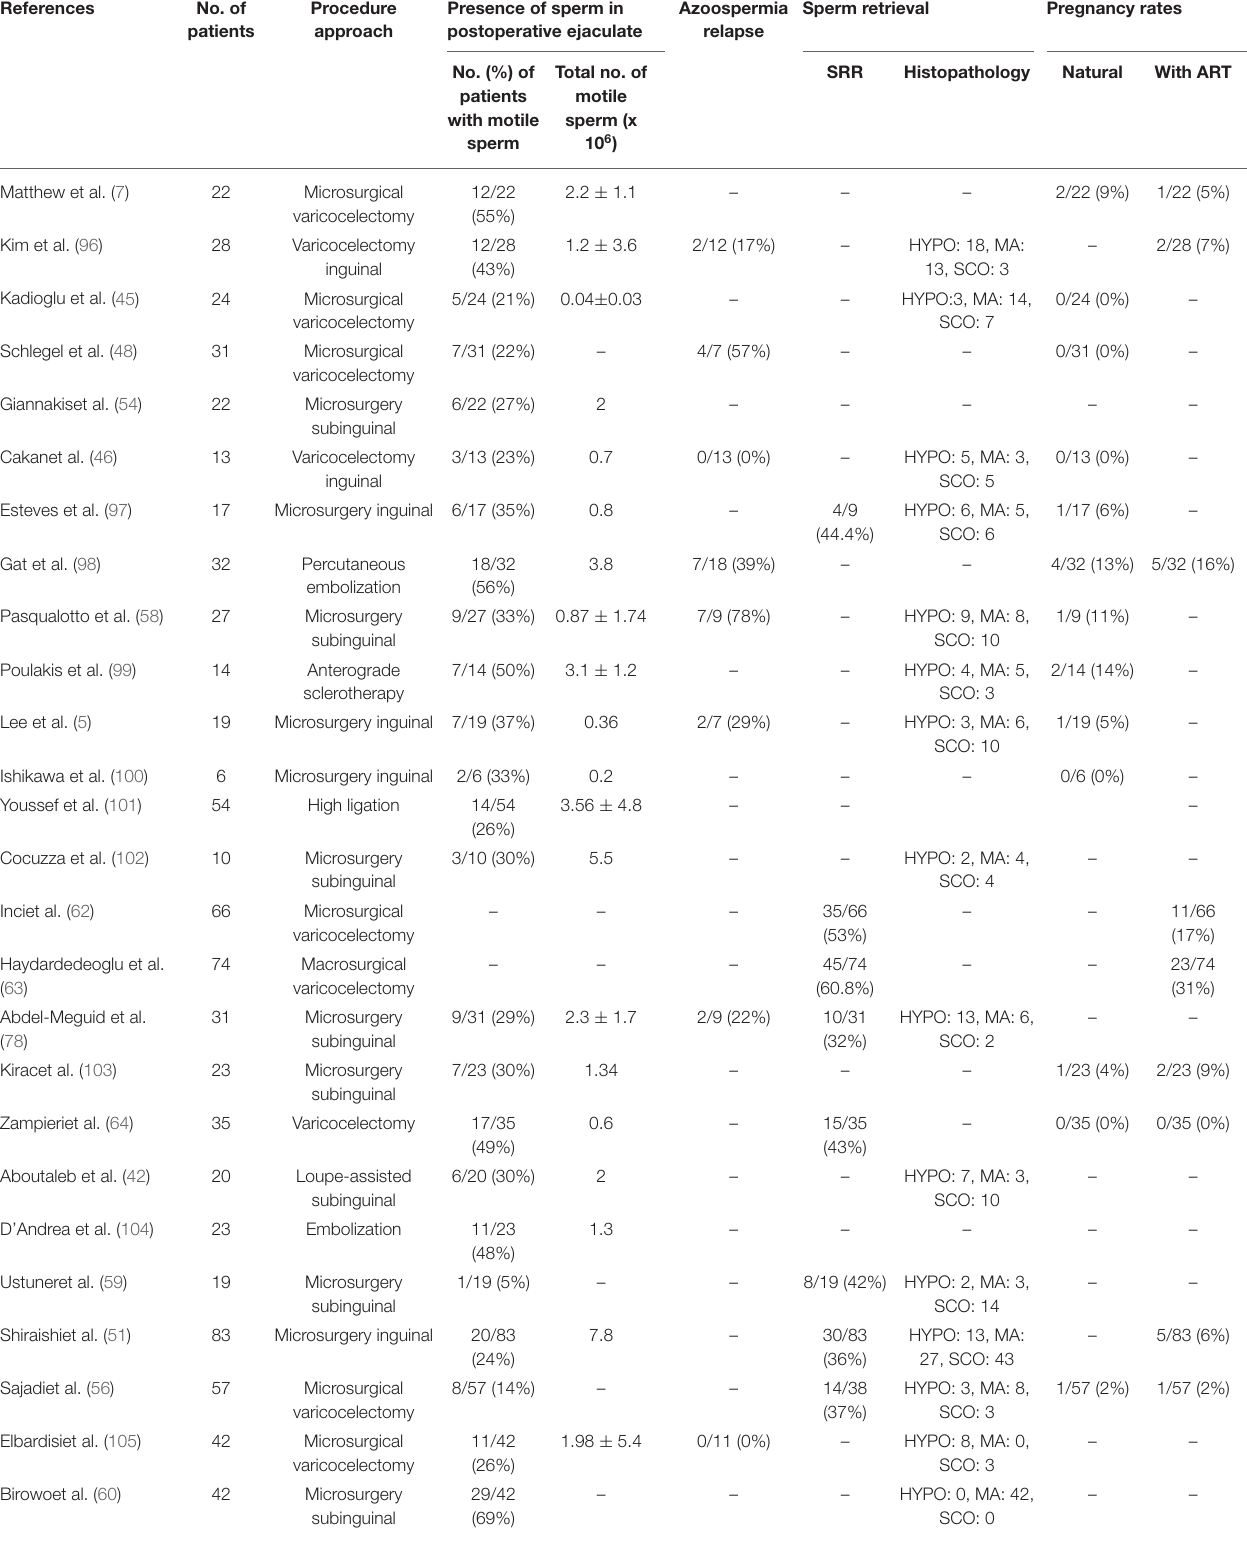
TABLE 1 | Studies describing the outcome of varicocelectomy on the appearance of spermatozoa in semen, SRR, and pregnancy rates post-ICSI